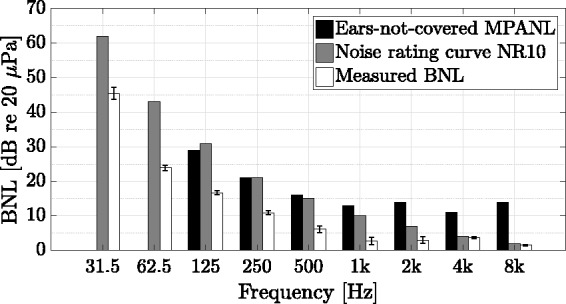
Mean BNL in the example listening environment plotted alongside ears-not-covered MPANLs, defined by ANSI/ASA S3.1 (1999), and the adequate noise rating curve NR10 (ISO 1996, 2016). Error bars indicate 95% confidence intervals of the mean.Note. BNL = background noise level; MPANLs = maximum permissible ambient noise levels.